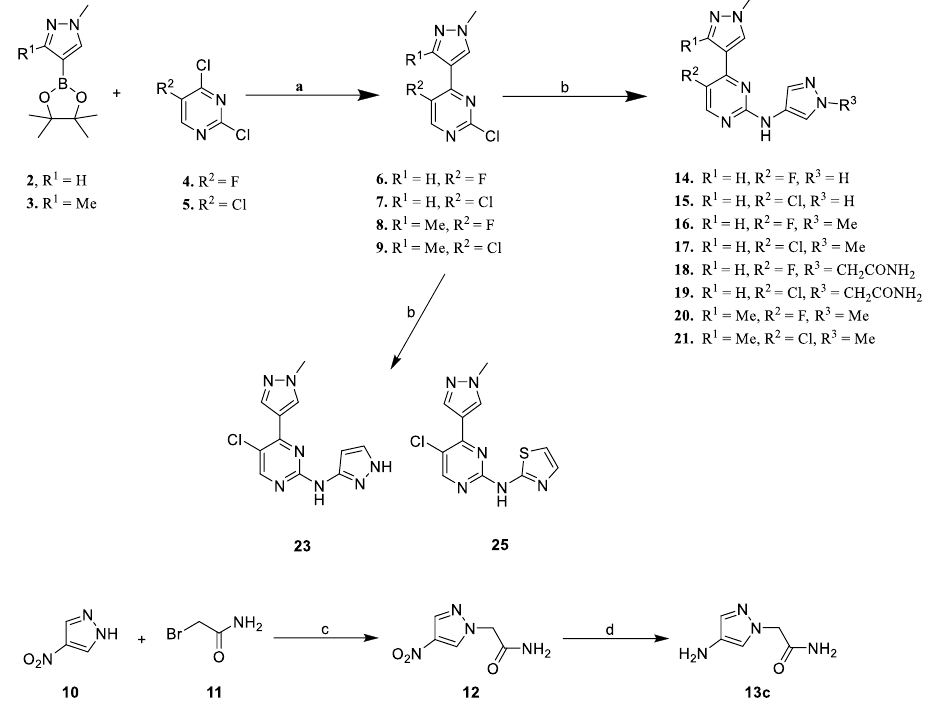
Scheme 1 . Synthesis of N ,4-di(1 H -pyrazolyl)pyrimidin-2-amines 14–21 and 23 and N -(5-chloro-4-(1- methyl-1 H -pyrazol-4-yl)pyrimidin-2-yl)thiazol-2-amine 25 . Reagents and conditions: